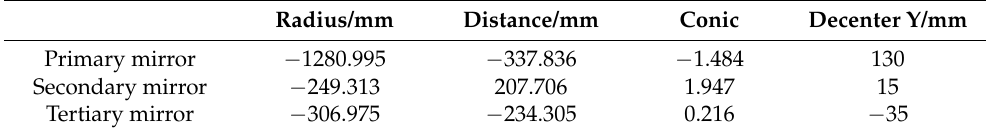
Table 7. Structural parameters of optimized RSIS.